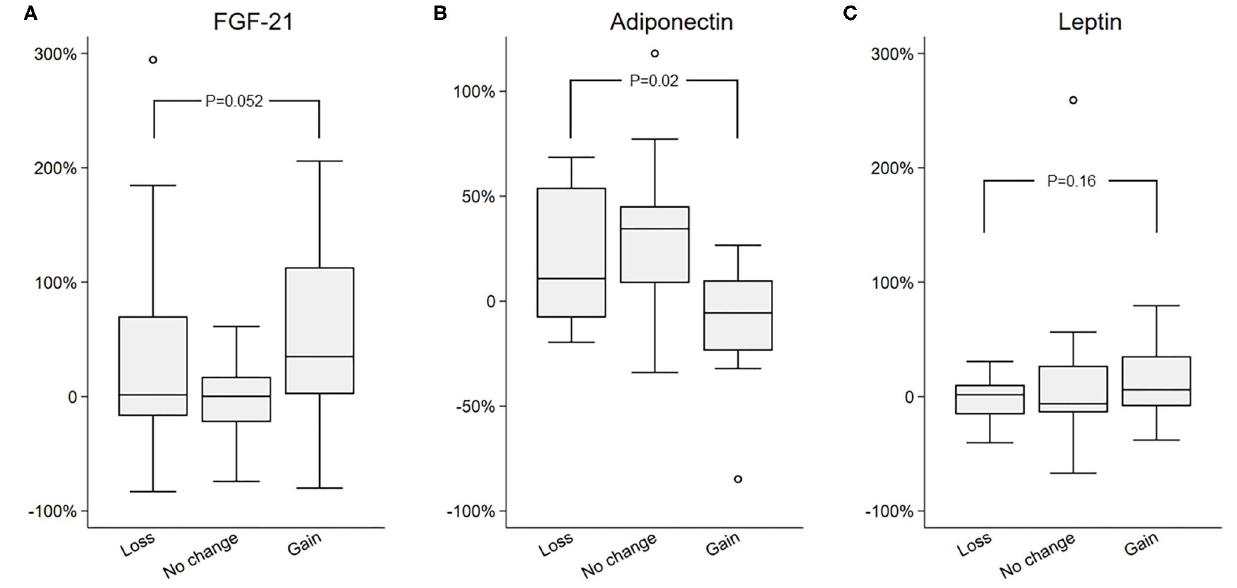
with type 2 diabetes and NAFLD while no significant